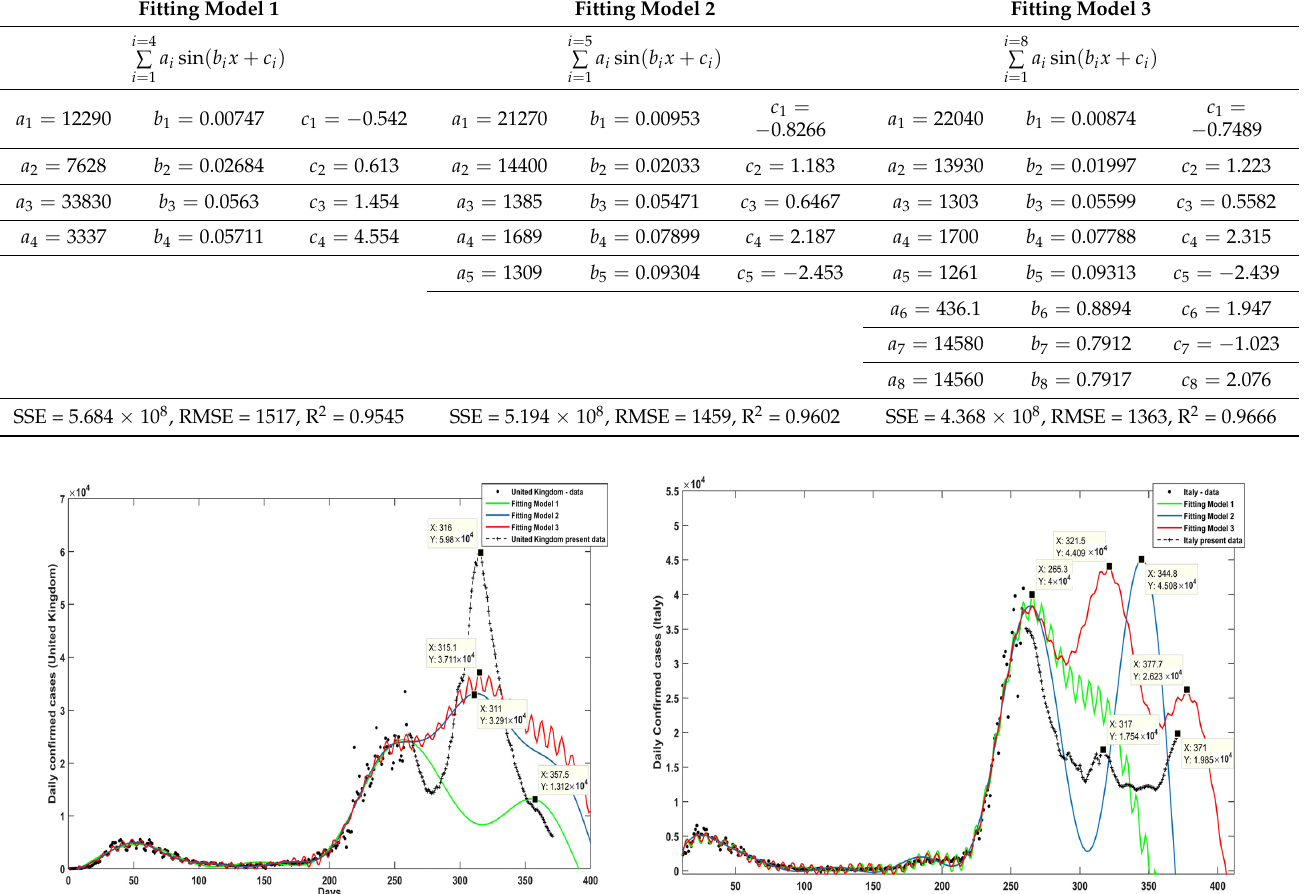
Table 4. Used mathematical fitting models for United Kingdom data with optimized coefficients. Fitting Model 1 Table 6. Used mathematical fitting models for Germany data with optimized coefficients. Fitting Model 1